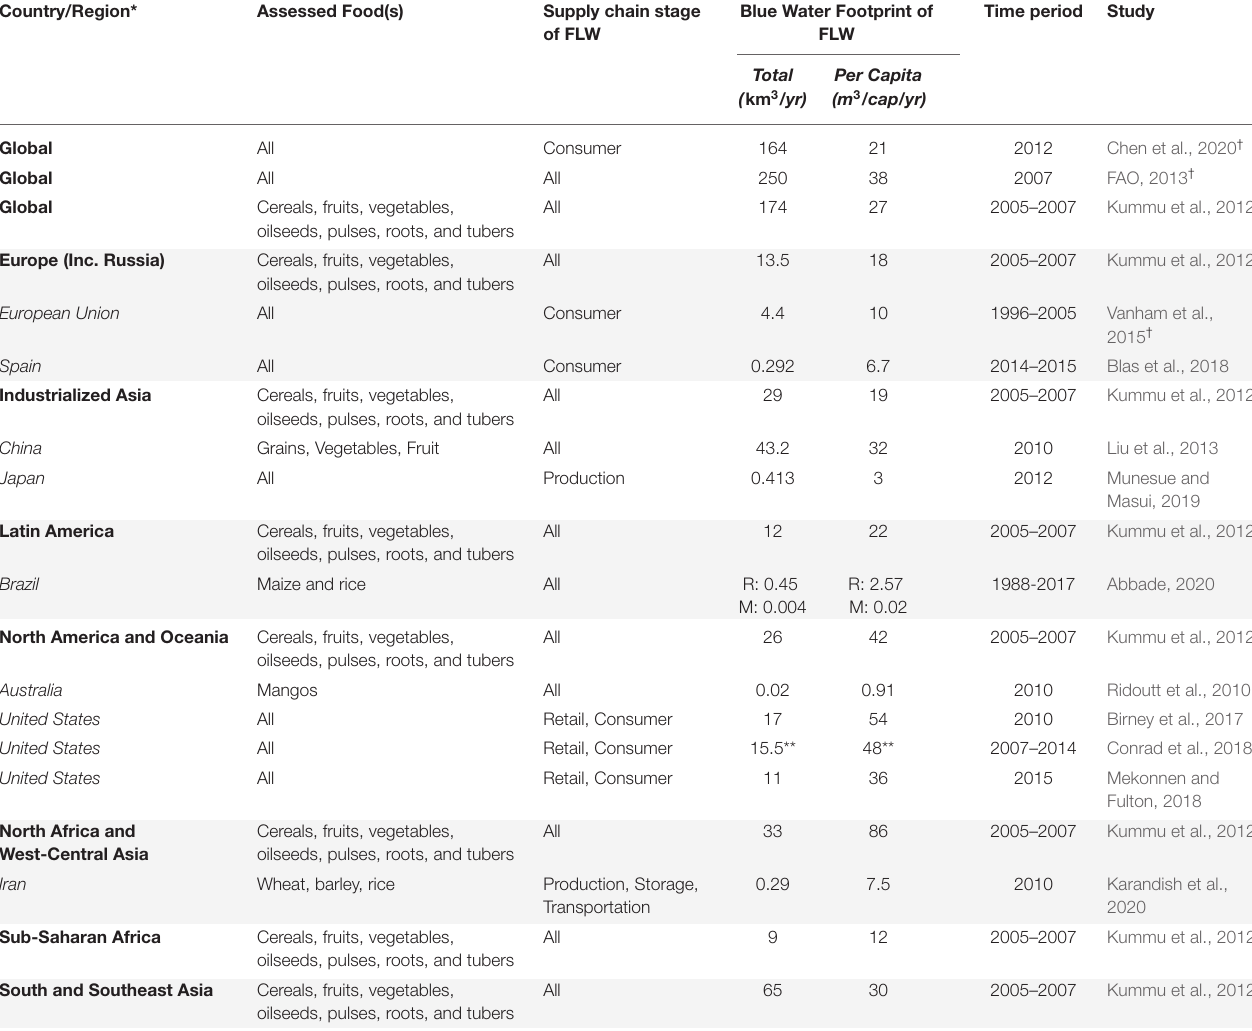
TABLE 1 | Summary of studies that evaluate the blue water footprint of food loss and/or waste (FLW) by country or region.